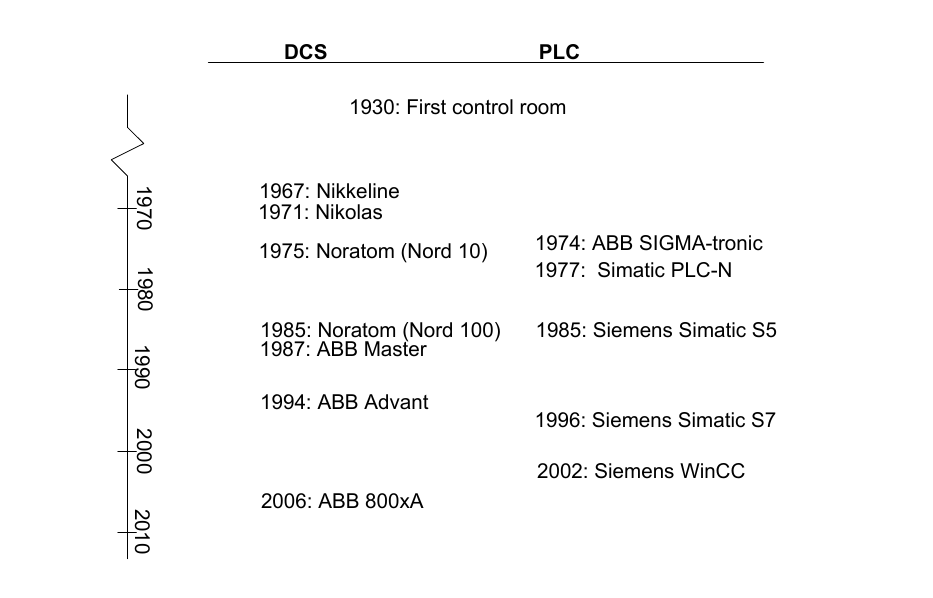
Figure 1: Chronological overview of DCS and PLC systems at Xstrata